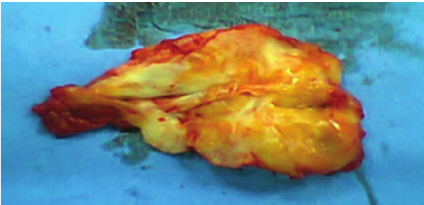
F 3: Surgical specimen of elasto�broma